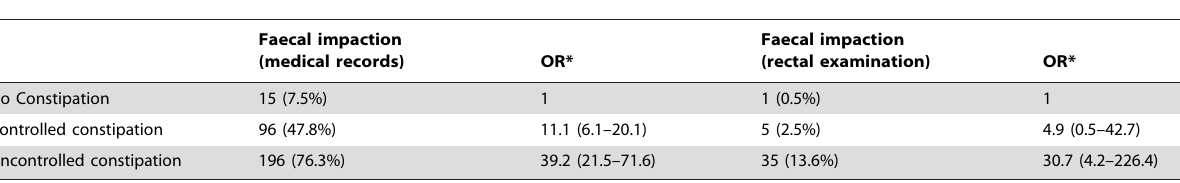
Table 3. Fecal Impaction and control of chronic